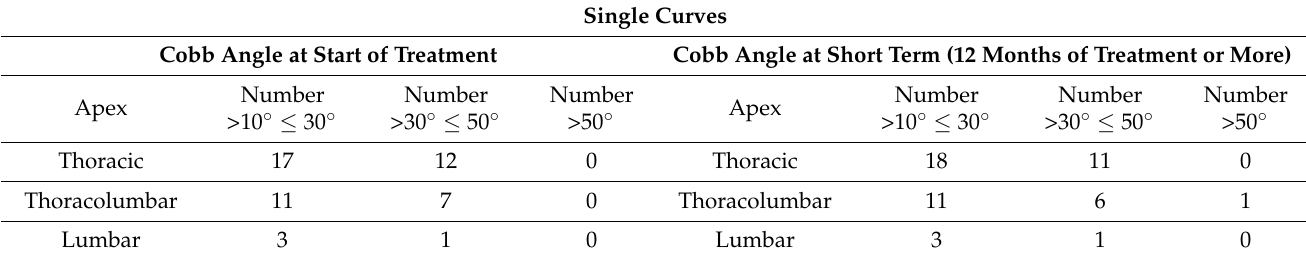
Table 6. Cobb angle changes for double curves. Single Curves